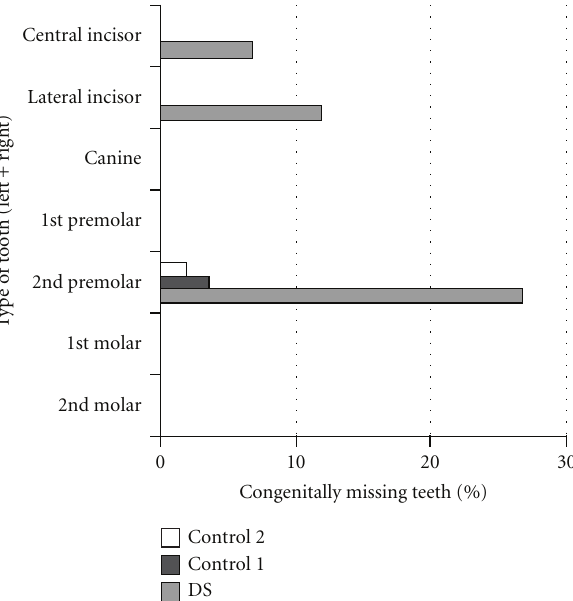
Figure 3: Comparison of missing mandibular teeth between the three groups.